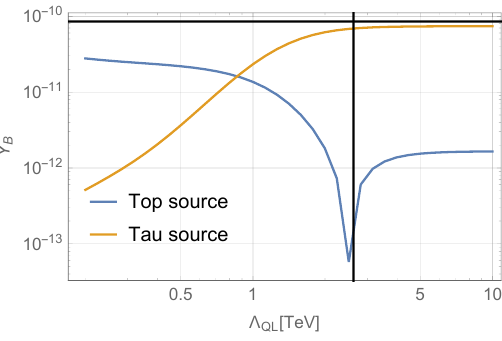
Figure 6 . Y B as function of (cid:3) QL for a top source with (cid:3) t = 7 : 1 (cid:2) 10 3 GeV (blue) and a lepton source with (cid:3) (cid:28) = 1 (cid:2) 10 3 GeV (yellow). The vertical black line corresponds to the new interactions rate being equal to the lepton Yukawa interaction rate. The horizontal black line corresponds to the measured value of the baryon